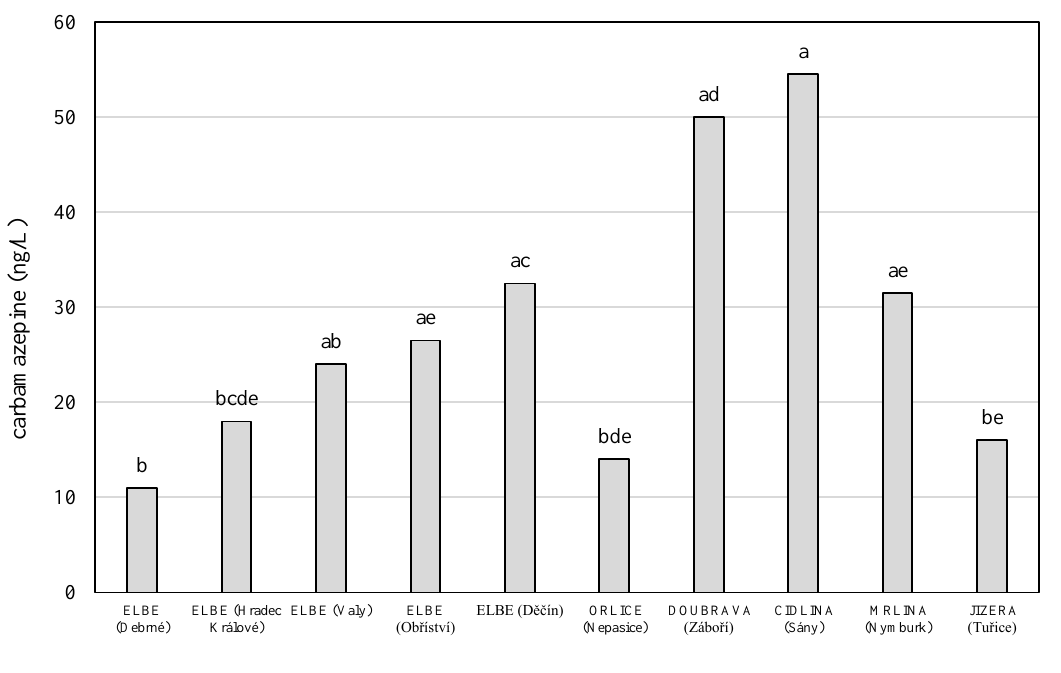
Figure 10. Median values of carbamazepine concentration at the sampled locations during the year 2021. Significant differences among the localities are indicated by different alphabetical superscripts ( p < 0.05).